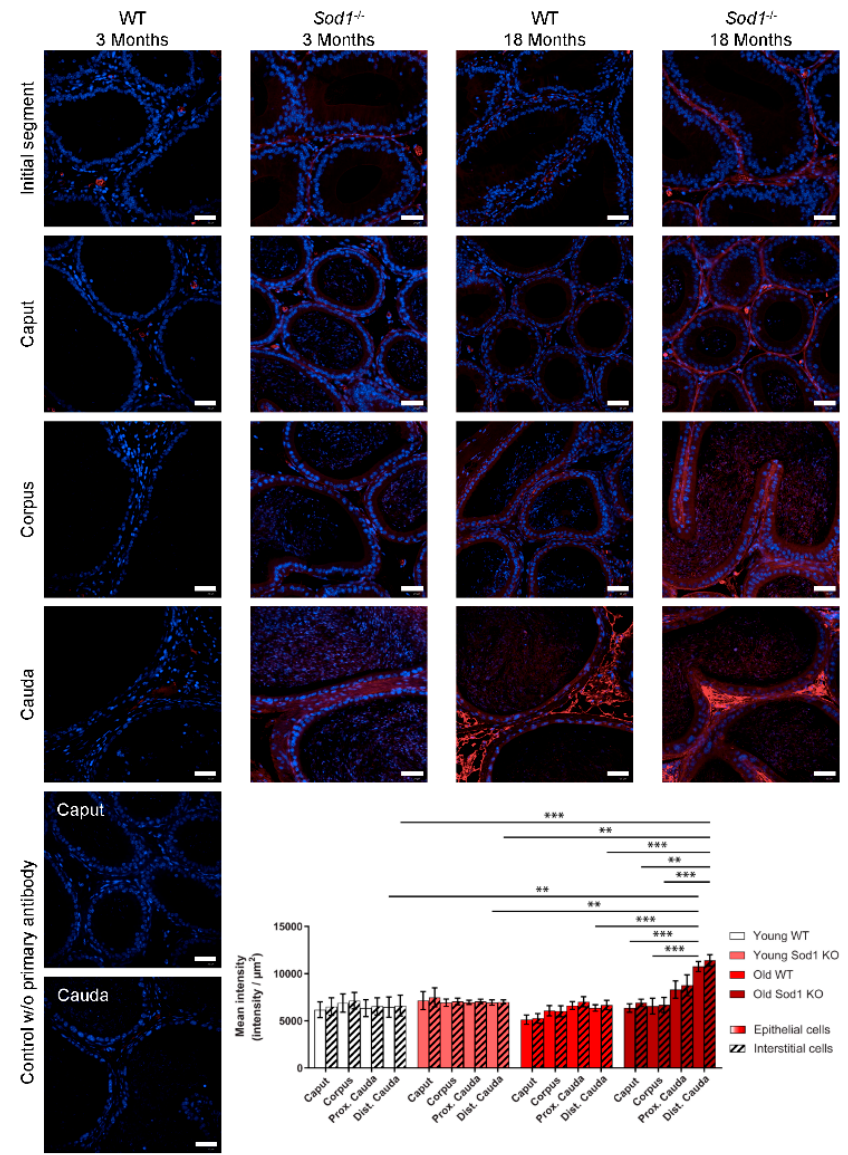
Figure 2. Aging induces an accumulation the nucleic acid damage in the epididymis (initial segment, caput, corpus, and cauda epididymides) which is enhanced in Sod1 − / − mice. Representative pictures of sections of the epididymis from 3-month-old and 18-month-old wild-type and Sod1 − / − mice after immunostaining of oxidized nucleic acids (8-OHG, red); the nuclei are counterstained with DAPI (blue). Immunostaining negative controls (no primary antibody) are displayed for the caput and cauda epididymides. Scale bar: 40 µm. 8-OHG staining was quantified separately in the epididymal epithelium (clear histograms) and in the interstitial tissue (dashed histograms). ** p < 0.01, *** p < 0.001 (3-way ANOVA, n = 4–5).